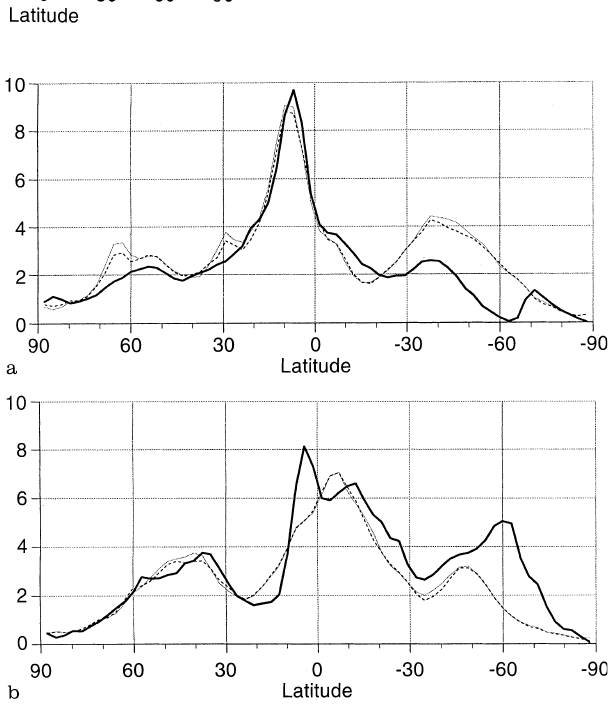
Fig. 4. Zonal mean precipitation (cid:133) mm day (cid:255) 1 (cid:134) for July: REF31 ( dotted ), GWD31 ( dashed ) and the climatology (